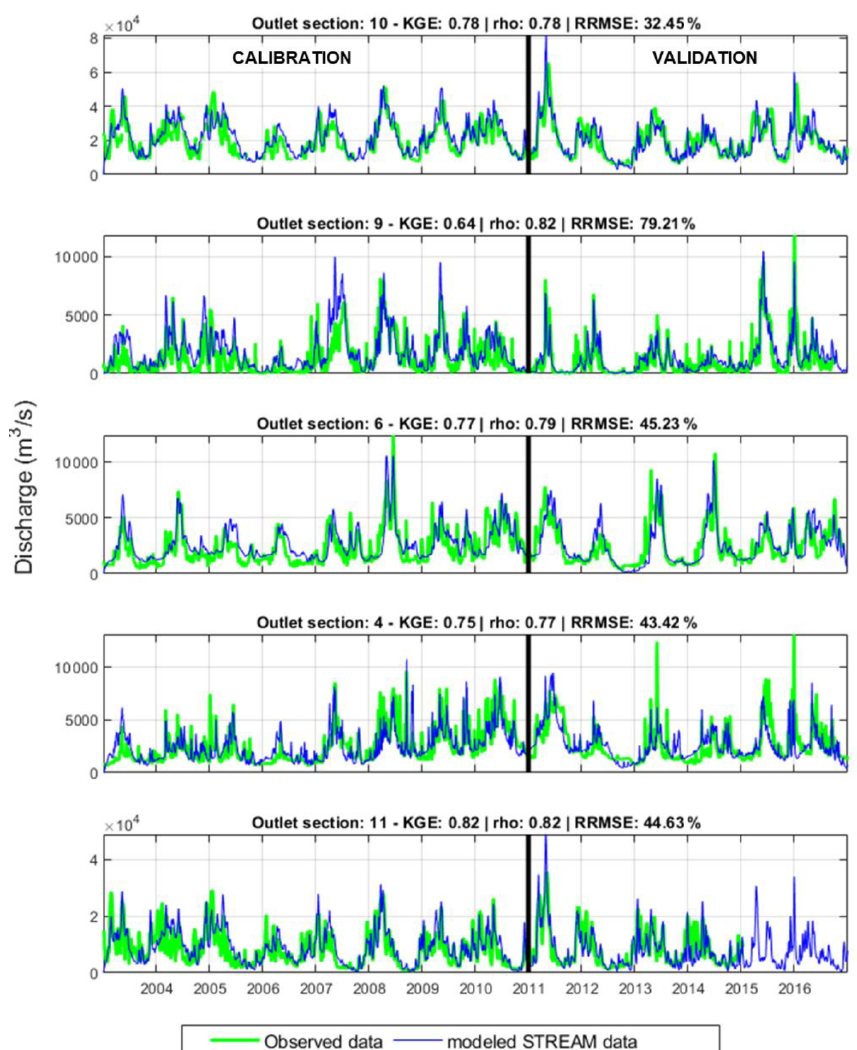
Figure 4. Comparison between observed and modeled river discharge time series over the five calibrated sections in the Mississippi River basin. Performance scores at the top of each plot refer to the entire study period